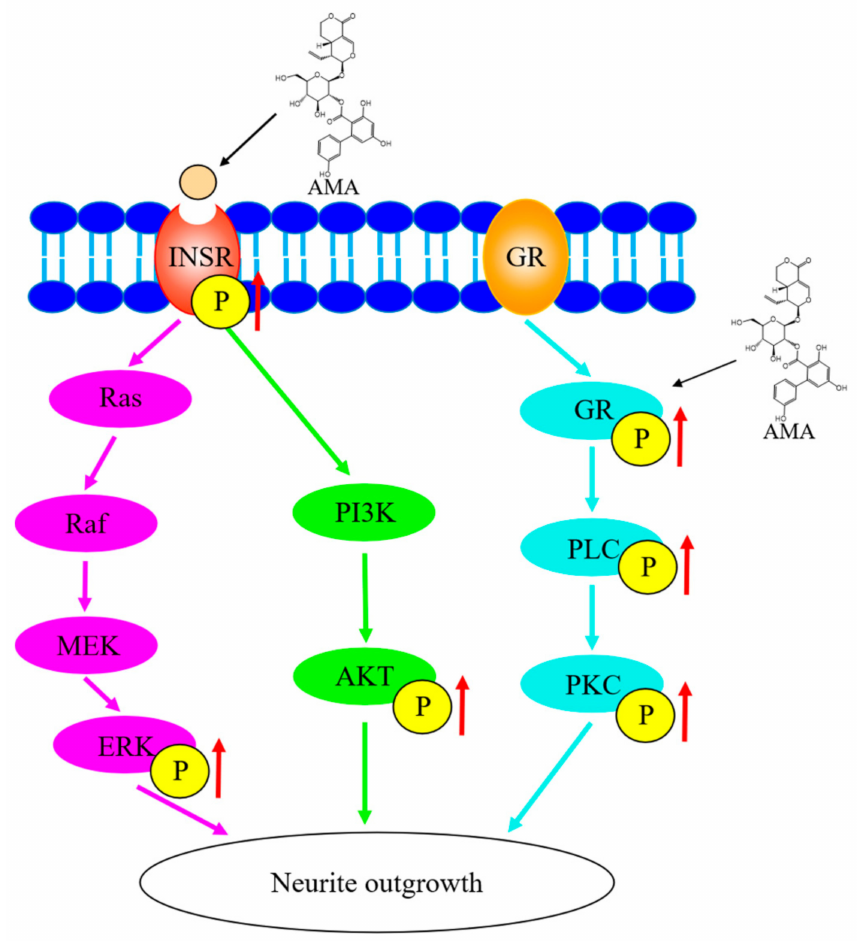
Figure 7. Proposed mechanism of the action of AMA in the neuritogenic activity in PC12 cells.